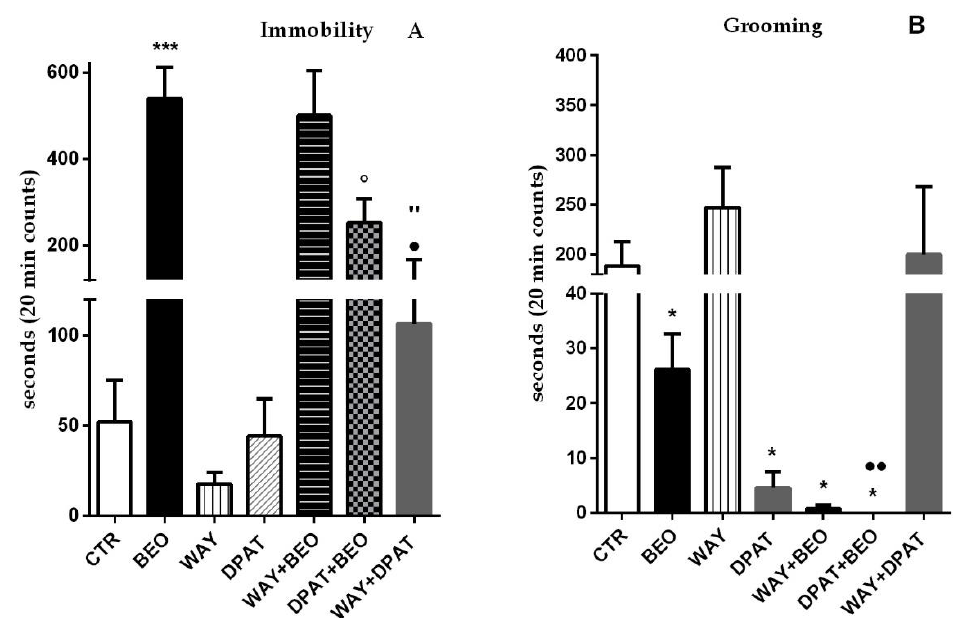
Figure 1. Immobility ( A ) and Grooming ( B ) in open field test in male Wistar rats after systemic (i.p.) administration of jojoba oil (CTR) (500 µL/kg), Bergamot Essential Oil (BEO) (500 µL/kg), WAY100635 (WAY) (1 mg/kg), 8-OH-DPAT (DPAT) (1 mg/kg), WAY + BEO (1 mg/kg + 500 µL/kg), DPAT + BEO (1 mg/kg + 500 µL/kg), and WAY + DPAT (1 mg/kg + 1 mg/kg). Data are expressed as mean ± SEM ( n = 5–6 per group). * p < 0.05 and *** p < 0.001 vs. control group; ° p < 0.05 vs. BEO group; • p < 0.05 and •• p < 0.01 vs. DPAT group; “ p < 0.05 vs. WAY group. Statistical analysis was performed by one- or two-way ANOVA followed by individual comparisons with Tukey Multiple Comparison’s test.